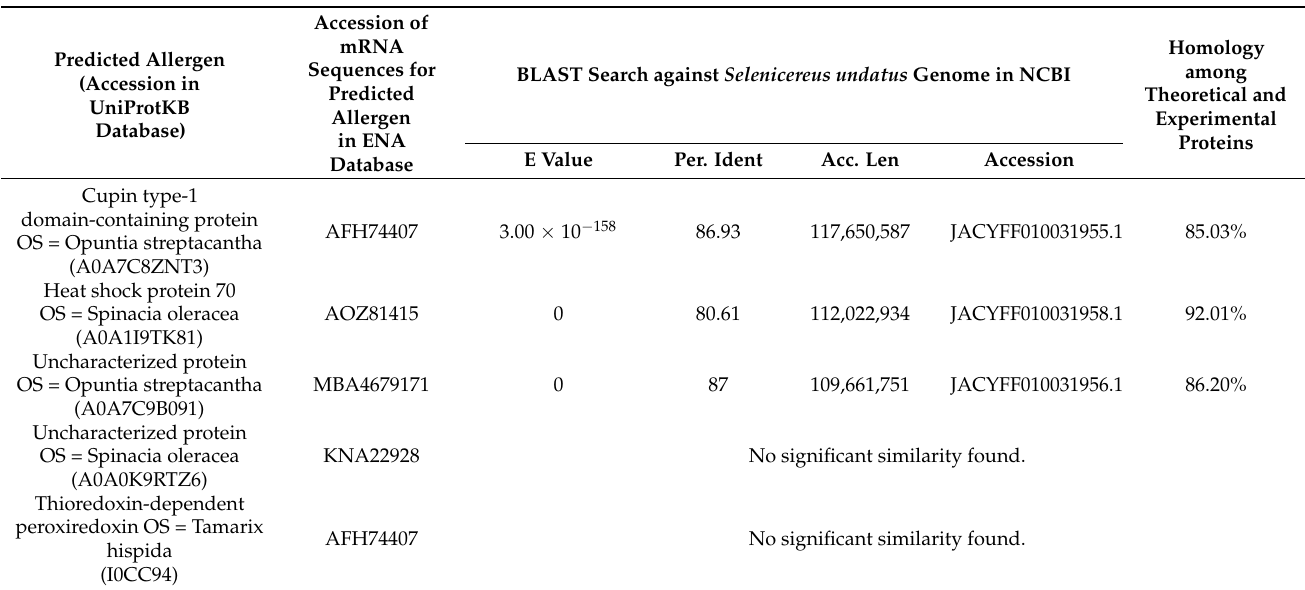
Table 5. mRNA sequences of potential allergens Blast against Selenicereus undatus genome in the NCBI database.